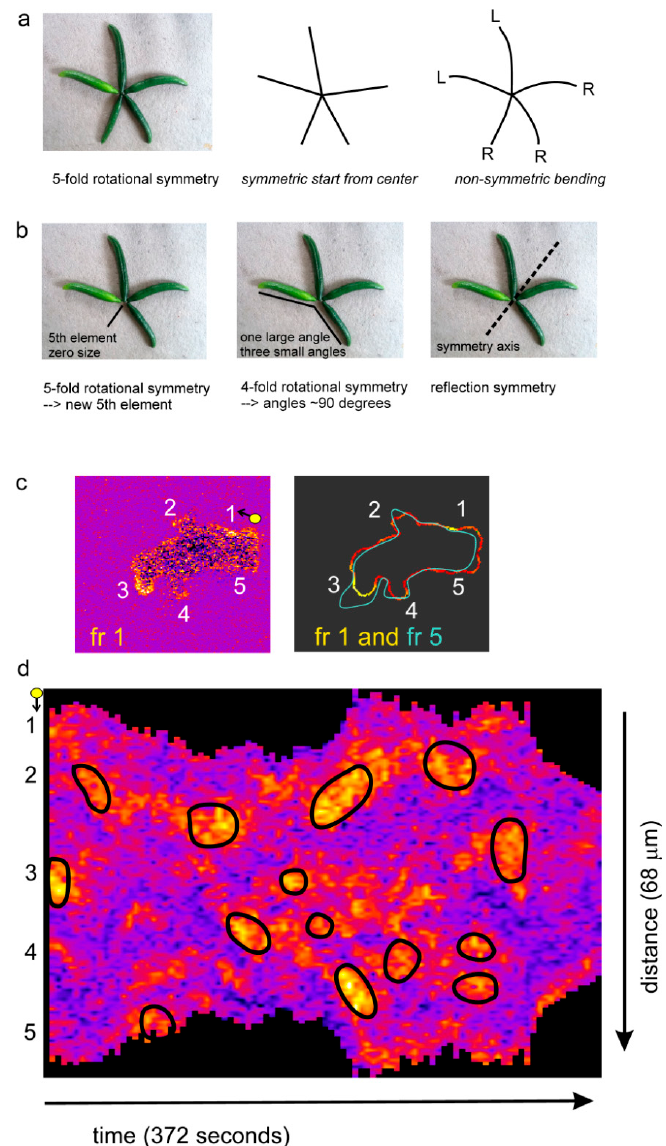
Figure 1. Fundaments of symmetry and dynamic symmetry breaking. ( a ) Symmetry in biology may depend on the viewpoint. The image is an object with 5 elements. The drawing in the middle connects the center of the object with the ends of the elements, showing approximately 5-fold rotational symmetry. The drawing on the right follows the curvature of the elements, showing that the object has poor 5-fold symmetry. ( b ) Distortion of symmetry. Removing one element leads to poor 4-fold and poor 5-fold rotational symmetry, but to very good reflection symmetry. Symmetry can recover in different ways, depending on the underlying molecular mechanism. ( c , d ) Unpolarized early Dictyostelium cells expressing RBD-Raf-GFP and cytosolic-RFP were followed in time at 4 s per frame, providing a very sensitive sensor for active Ras-GTP. The intensity at the boundary of the cell was measured and is presented in the kymograph. ( c ) Image of frame 1 reveals multiple Ras patches with approximately 5-fold rotational symmetry; the outline of the cell in frame 5 reveals that a pseudopod was extended at Ras-GTP patch 3. In frame 6 a pseudopod will start in patch 2. ( d ) The kymograph reveals about 53 Ras-GTP patches and 14 extending pseudopods (indicated by the back circles); ( c , d ) are redrawn from [4].